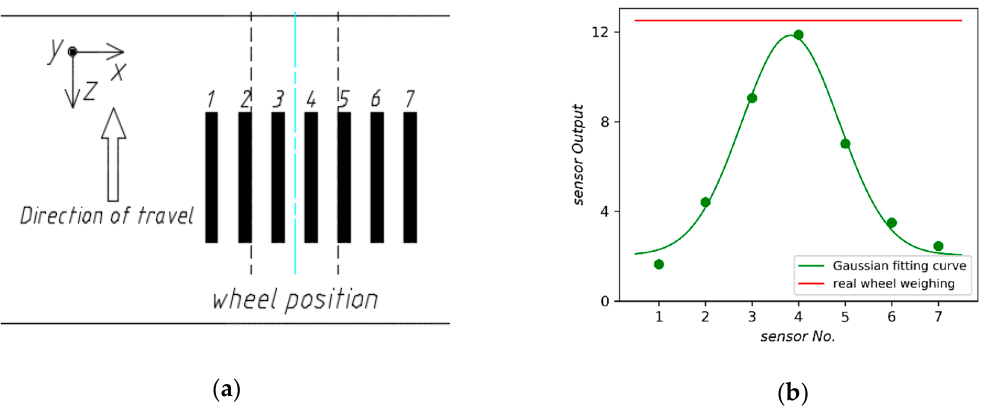
Figure 21. ( a ) The array with seven longitudinal sensors; ( b ) Gaussian fitting curve.